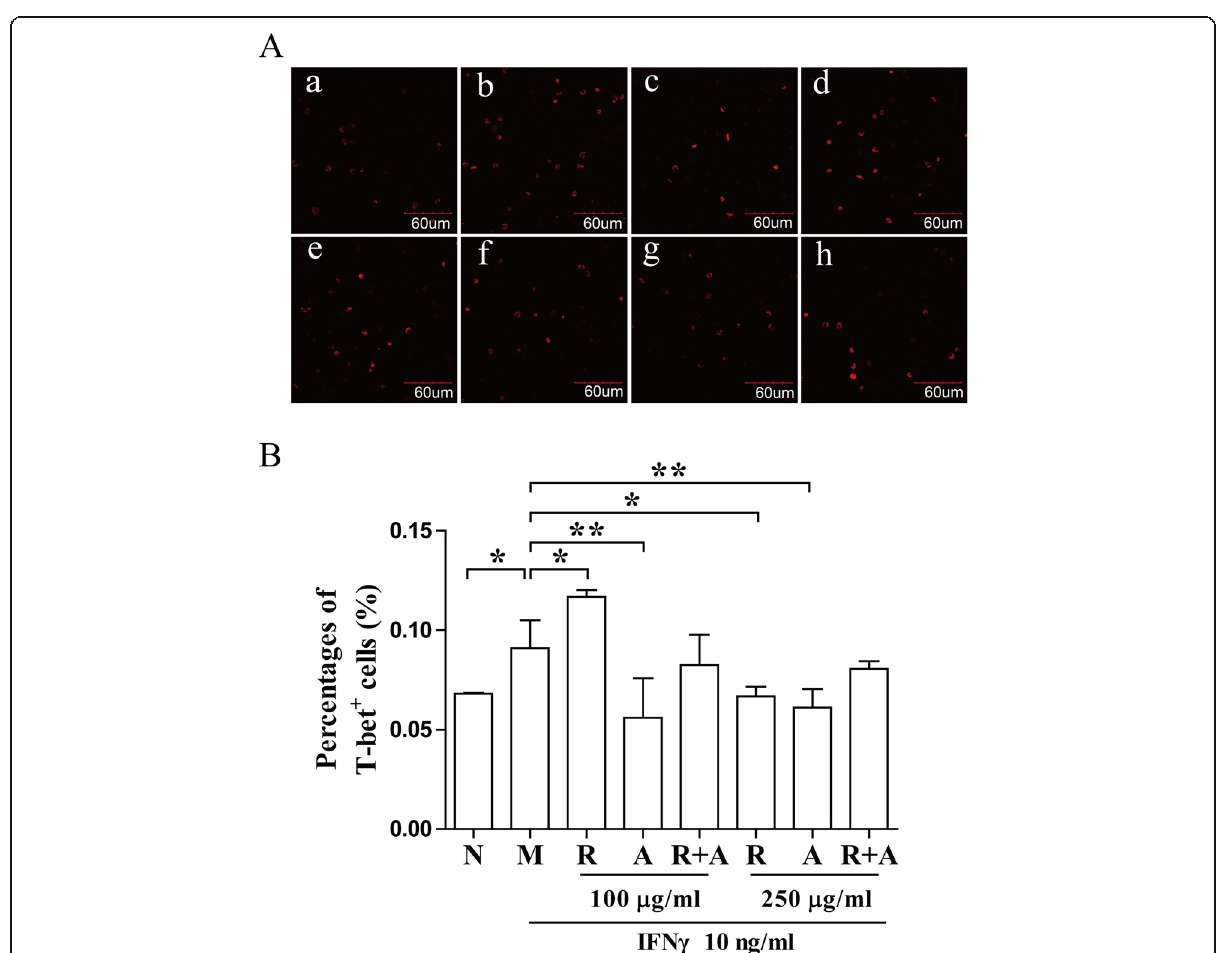
Fig. 7 Interference in the expression and distribution of T-bet in BM cells after 12 h of treatment. ( a ) Staining for T-bet (red) in BM cells was observed by confocal immunofluorescence microscopy. The stained cells (red) were quantitated with ImageJ. The scale bar corresponds to 60 μ m throughout. ( b ) The quantified results are presented in a bar chart. a, Normal (N) group; b, Model (M) group; c and f, Radix Astragali (R) group; d and g, Radix Angelicae Sinensis (A) group; e and h, Radix Astragali + Radix Angelicae Sinensis (R + A) group; c, d and e were treated with 100 μ g/mL of freeze-dried powders and f, g and h were treated with 250 μ g/mL of freeze-dried powders. Data are presented as the mean ± SD, n = 3. * P < 0.05 and ** P <